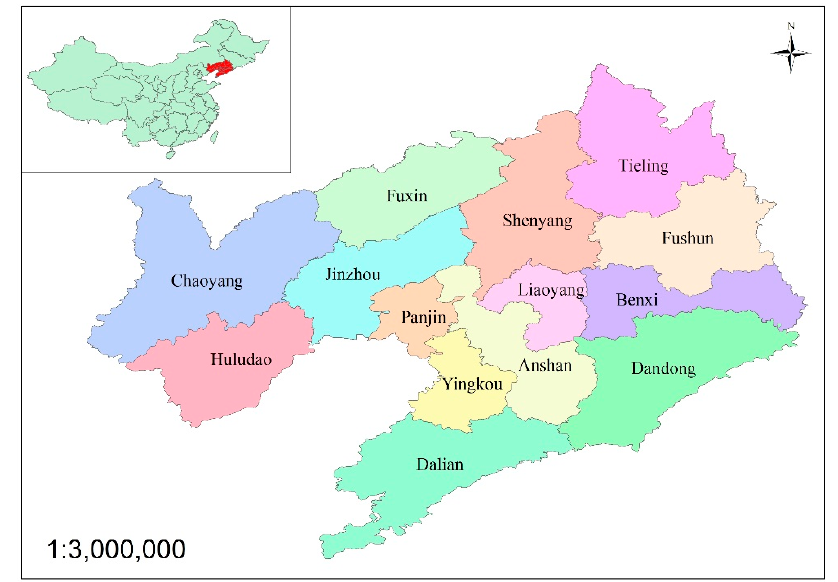
Figure 1. The map of Liaoning Province, China.